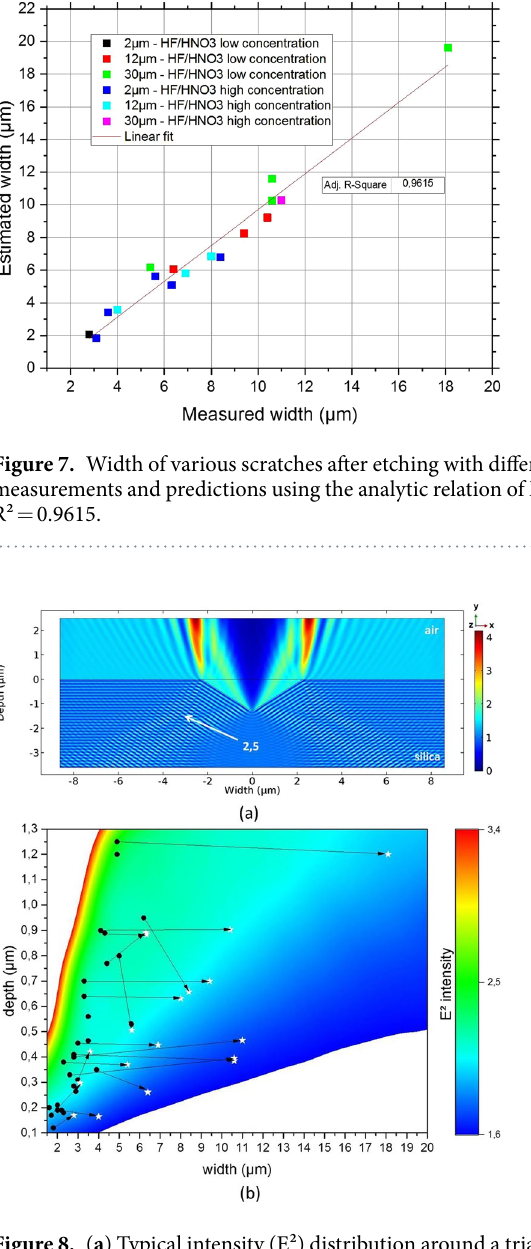
Figure 8. ( a ) Typical intensity (E²) distribution around a triangle-shaped scratch in TE polarization; ( b ) Evolution of the intensity maximum in the fused silica induced by a triangle-shaped scratch as a function of triangle depth and width. Intensity maximum was obtained by simulations performed under TE polarization. Circles correspond to the depth/width of real scratches before etching. Stars represent the scratch width/depth after chemical etching with different etching conditions (detailed in Figs 6 and